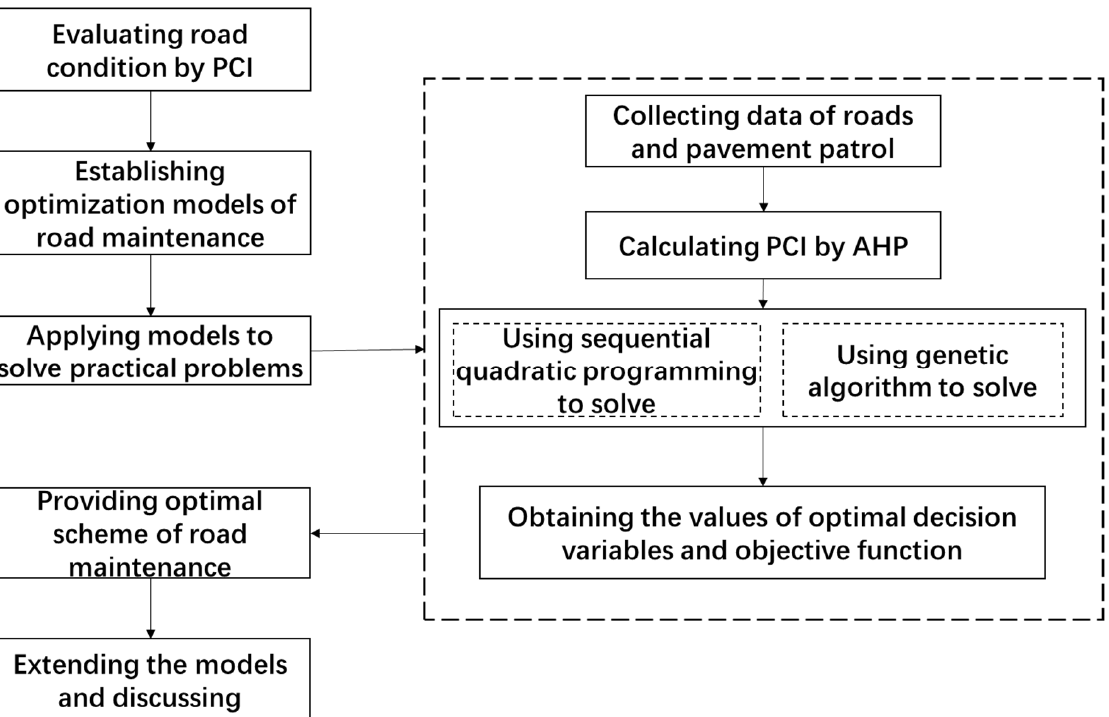
Figure 1. Overall flowchart of decision-making optimization for pavement maintenance.